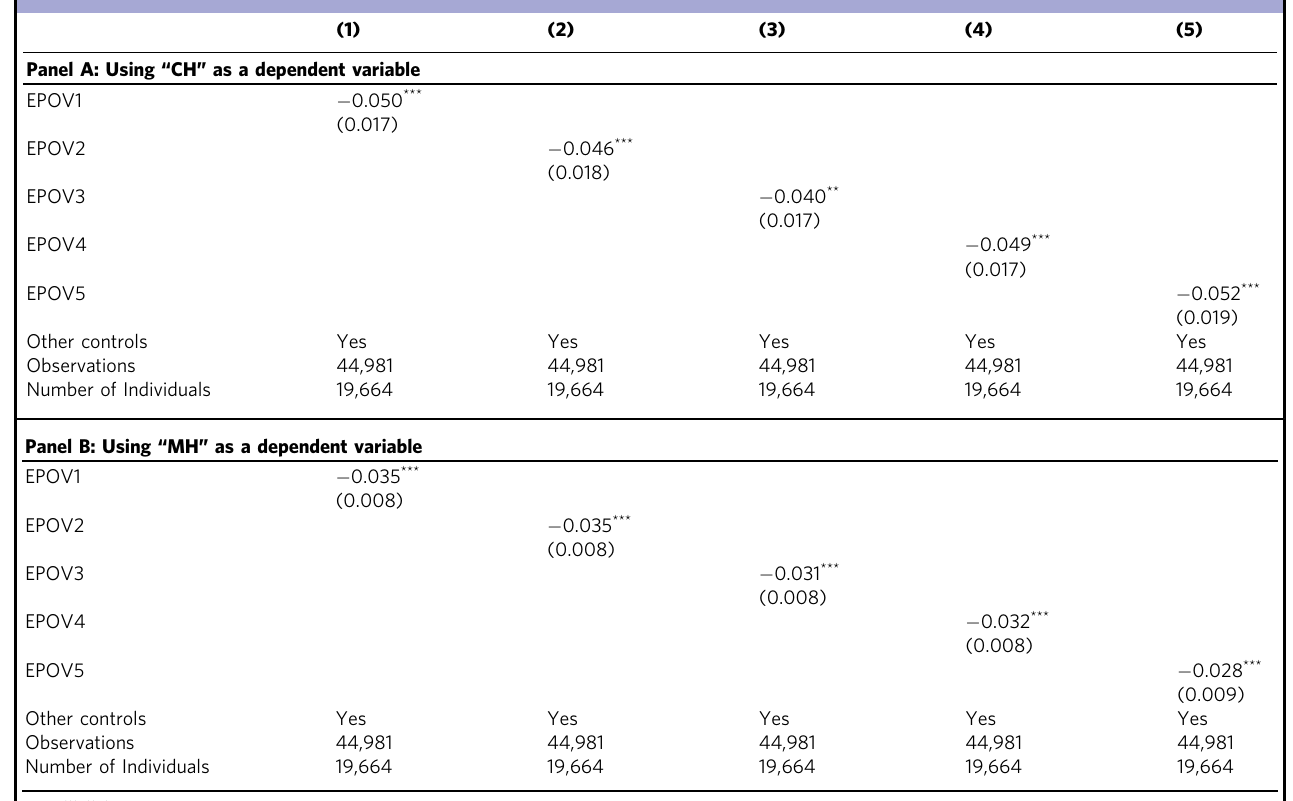
Table 5 Robustness checks (alternative measures of EPOV).